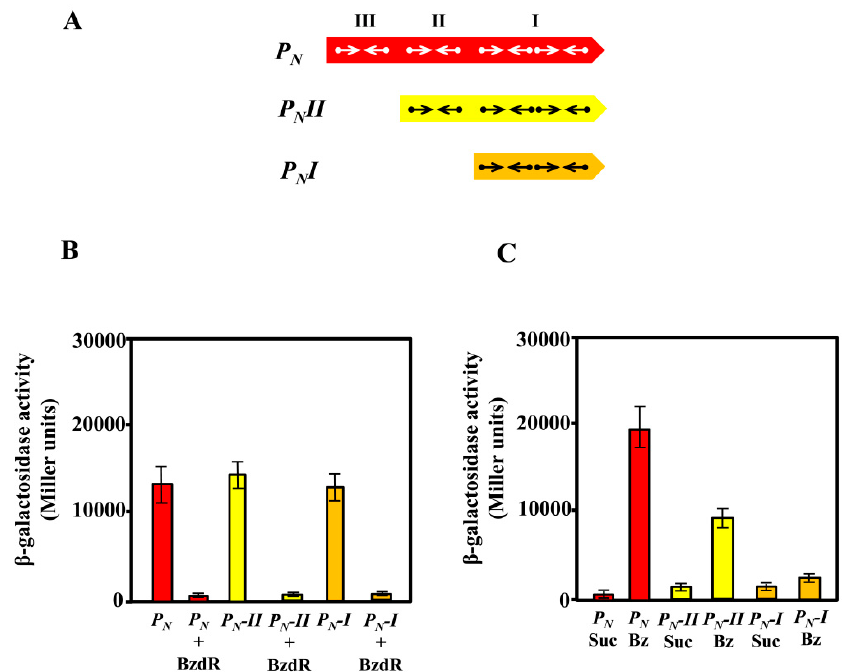
Figure 3. Activity of the P N , P N I , and P N II promoters in Escherichia coli and Azoarcus sp. CIB cells. ( A ) Schematic representation of the P N , P N II , and P N I promoters. Arrows represent the inverted repeat TGCA sequences for BzdR binding at operator regions I, II, and III. ( B ) The activity of the promoters was analyzed in E. coli MC4100 cells harboring the control plasmid pCK01 or plasmid pCK01-BzdR that expresses the bzdR gene (BzdR), and the plasmids pSJ3-P N , pSJ3-P N I, or pSJ3-P N II that harbor the